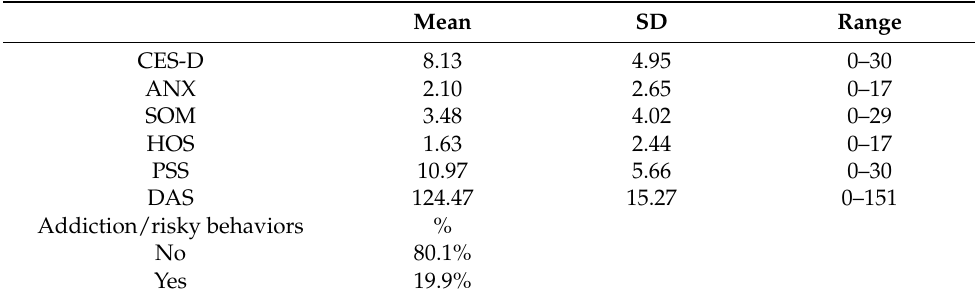
Table 2. Descriptive statistics of our study